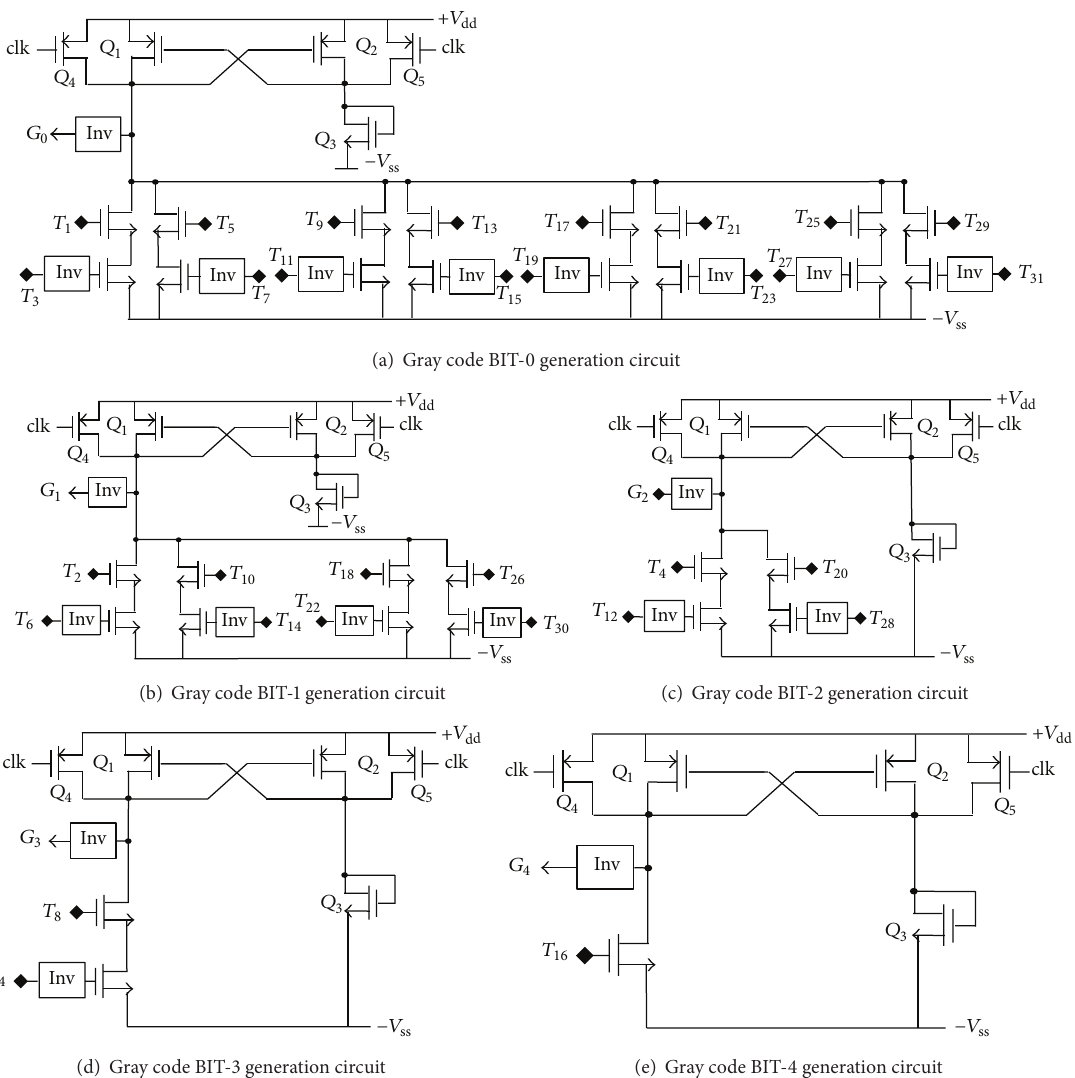
Figure 6: Schematic of Gray Code encoder using DCVS